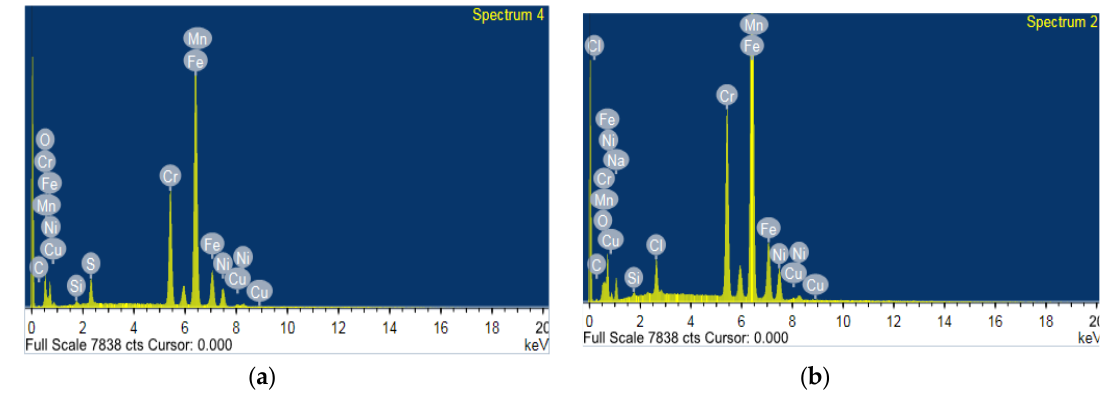
Figure 14. Energy dispersive X-ray (EDS) analysis after potentiodynamic polarization of ( a ) Figure14. EnergydispersiveX-ray(EDS)analysisafterpotentiodynamicpolarizationof( a )conventional conventional rebar and ( b ) DP rebar. rebar and ( b ) DP